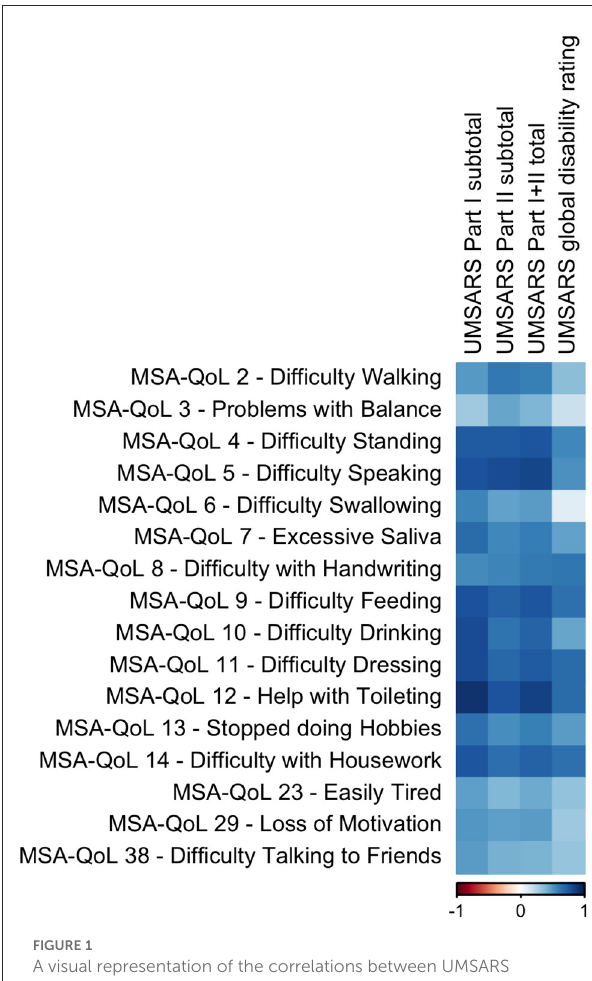
FIGURE1 A visual representation of the correlations between UMSARS domains and selected individual MSA-QoL items. A dark blue square represents a correlation coefficient that is close to 1 and a dark red square represents a correlation coefficient that is close to − 1, as shown in the